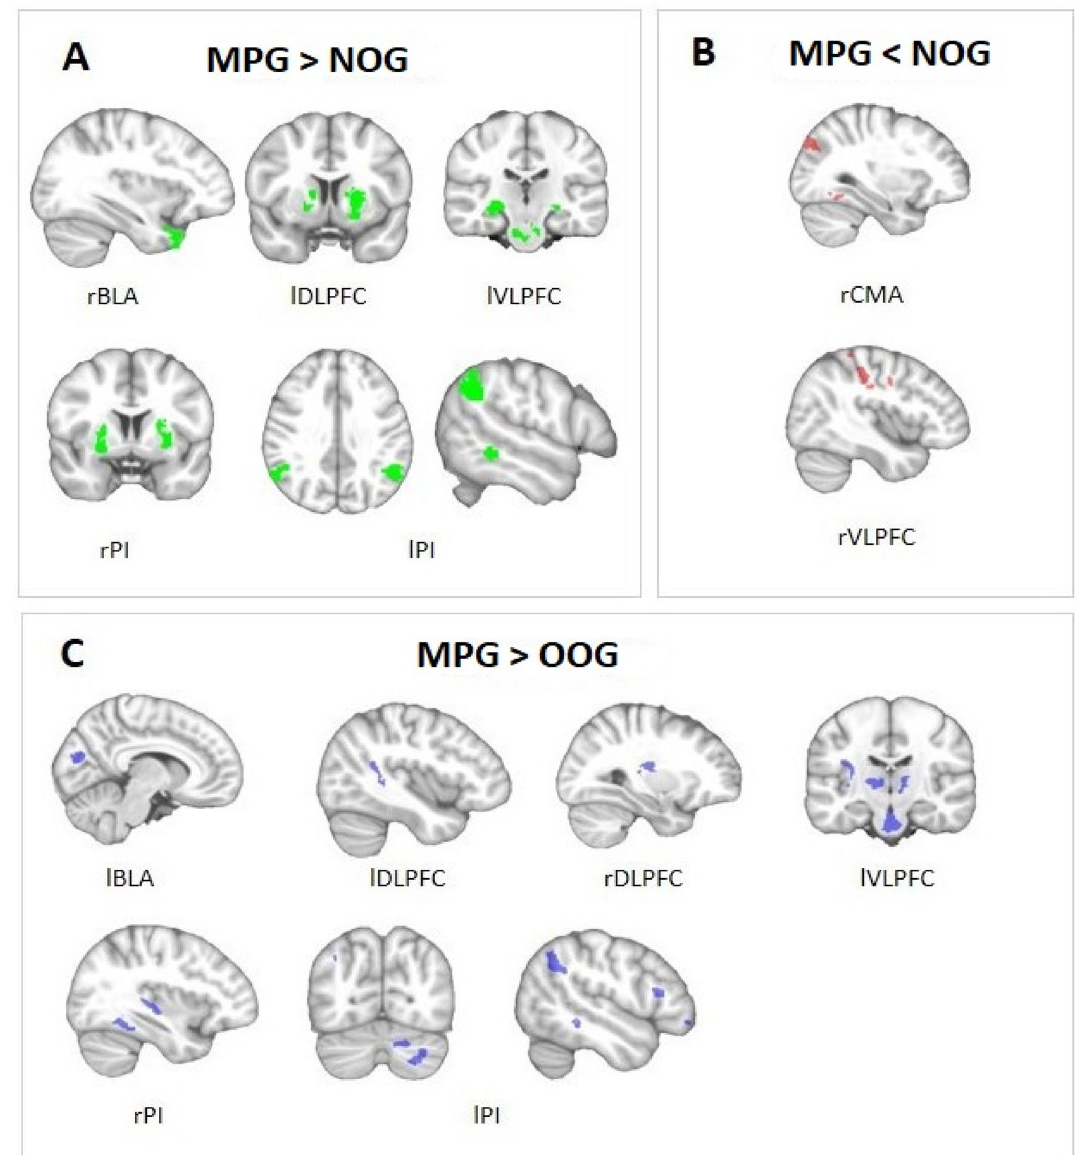
Figure 1. Significant group differences in seed-based analysis. Each brain image represents the correlations with the seed written below. MPG male perpetrators group, OOG other offenders group, NOG non-offenders group. ( A ) MPG demonstrated higher functional connectivity than NOG between rBLA (right basolateral amygdala) and temporal pole, between lVLPFC (left ventrolateral prefrontal cortex) and brainstem, middle temporal area and bilateral hippocampus, between lDLPFC (left dorsolateral prefrontal cortex) and putamen- caudate, between rPI (right posterior insula) and putamen and finally between lPI (left posterior insula) and bilateral angular gyrus and middle temporal area. ( B ) MPG demonstrated lower functional connectivity than NOG between rCMA (right centromedial amygdala), intraparietal, fusiform gyrus, and occipital area, and between rVLPFC (right ventrolateral prefrontal cortex) and sensorimotor, premotor, intraparietal and occipital areas. ( C ) MPG showed higher functional connectivity in comparison to OOG between lBLA (left basolateral amygdala) and visual-cuneus, between lVLPFC (left ventrolateral prefrontal cortex) and brainstem, insular cortex and bilateral thalamus, between rDLPFC (right dorsolateral prefrontal cortex) and sensorimotor, between lDLPFC (left dorsolateral prefrontal cortex) and middle temporal gyrus, between rPI (right posterior insula) and fusiform gyrus and Heschl Gyrus, and finally between lPI (left posterior insula) and angular gyrus, middle temporal, putamen, dorsolateral cortex, cerebellum and inferior frontal